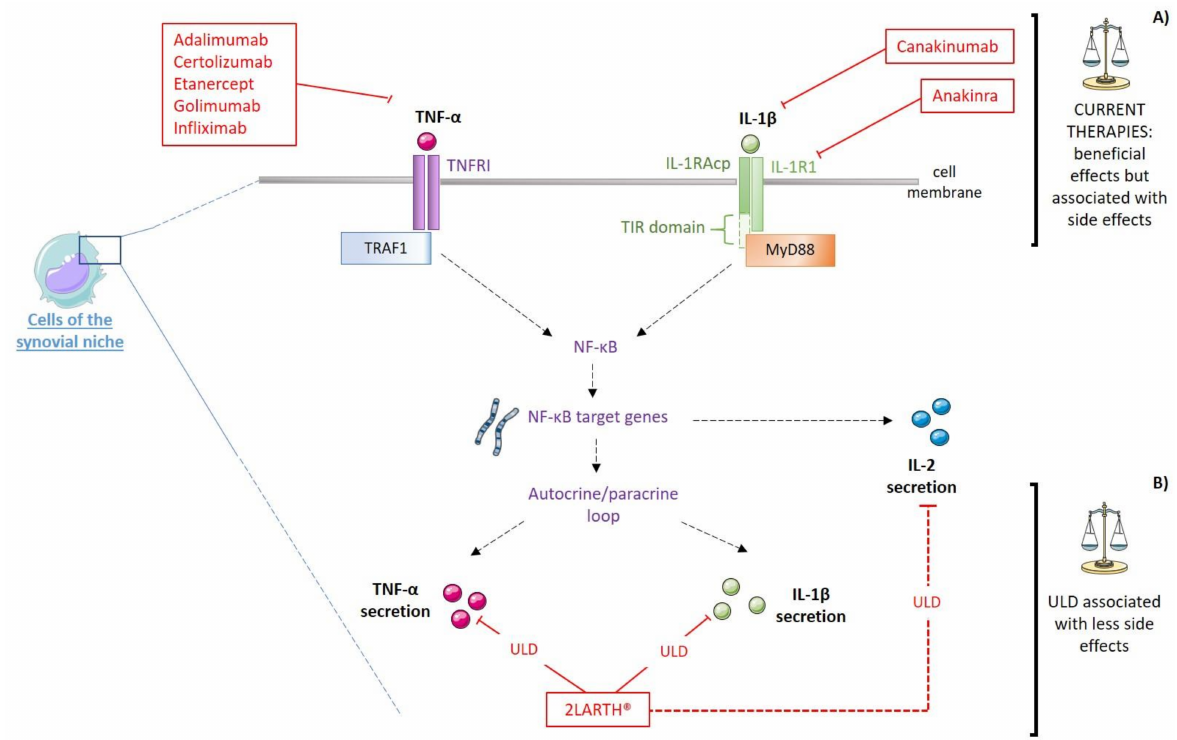
Figure 3. Schematic representation of ( A ) therapeutic targets of current treatments of RA and ( B ) the putative targets of 2LARTH ® : IL-1R1: Interleukin-1 type-I receptor; IL-1RAcP: IL-1 receptor accessory protein; MAPK: Mitogen-activated protein kinase; MyD88: Myeloid and differentiation primary response 88; NF- κ B: Nuclear factor- κ B; TIR: Toll-IL-1 receptor; TNFRI: TNF receptor type 1; TRAF1: TNF receptor-associated factor 1; ULD: Ultra-low dose. Red plain lines represent inhibition mechanisms, red dotted lines represent modulatory